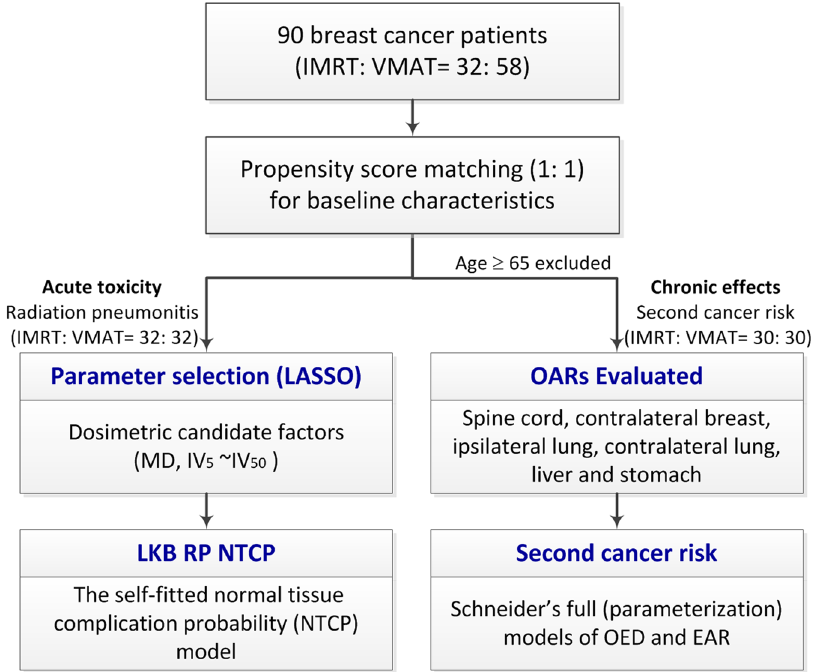
Figure 1. The process profile for this study. Abbreviations : LASSO, least absolute shrinkage and selection operator; IMRT, intensity-modulated radiotherapy; VMAT, volumetric-modulated arc therapy; RP, radiation- induced pneumonitis; IV 5 : the volume of the ipsilateral lung receiving at least 5 Gy; the following parameters are similar; IV 10 ∼ IV 50 ; NTCP, normal tissue complication probability; MD, mean dose to the ipsilateral lung; LKB, Lyman-Kutcher-Burman; OED, organ equivalent dose; EAR, excess absolute risks; OARs, organs at